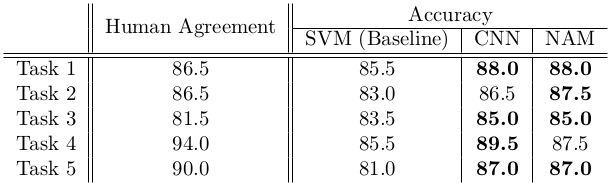
Table from the paper: Classification of Radiology Reports Using Neural Attention Models
Table text:
HumanAgreement
Accuracy
SVM(Baseline)
CNN
NAM
Task1
86.5
85.5
88.0
88.0
Task2
86.5
83.0
86.5
87.5
Task3
81.5
83.5
85.0
85.0
Task4
94.0
85.5
89.5
87.5
Task5
90.0
81.0
87.0
87.0